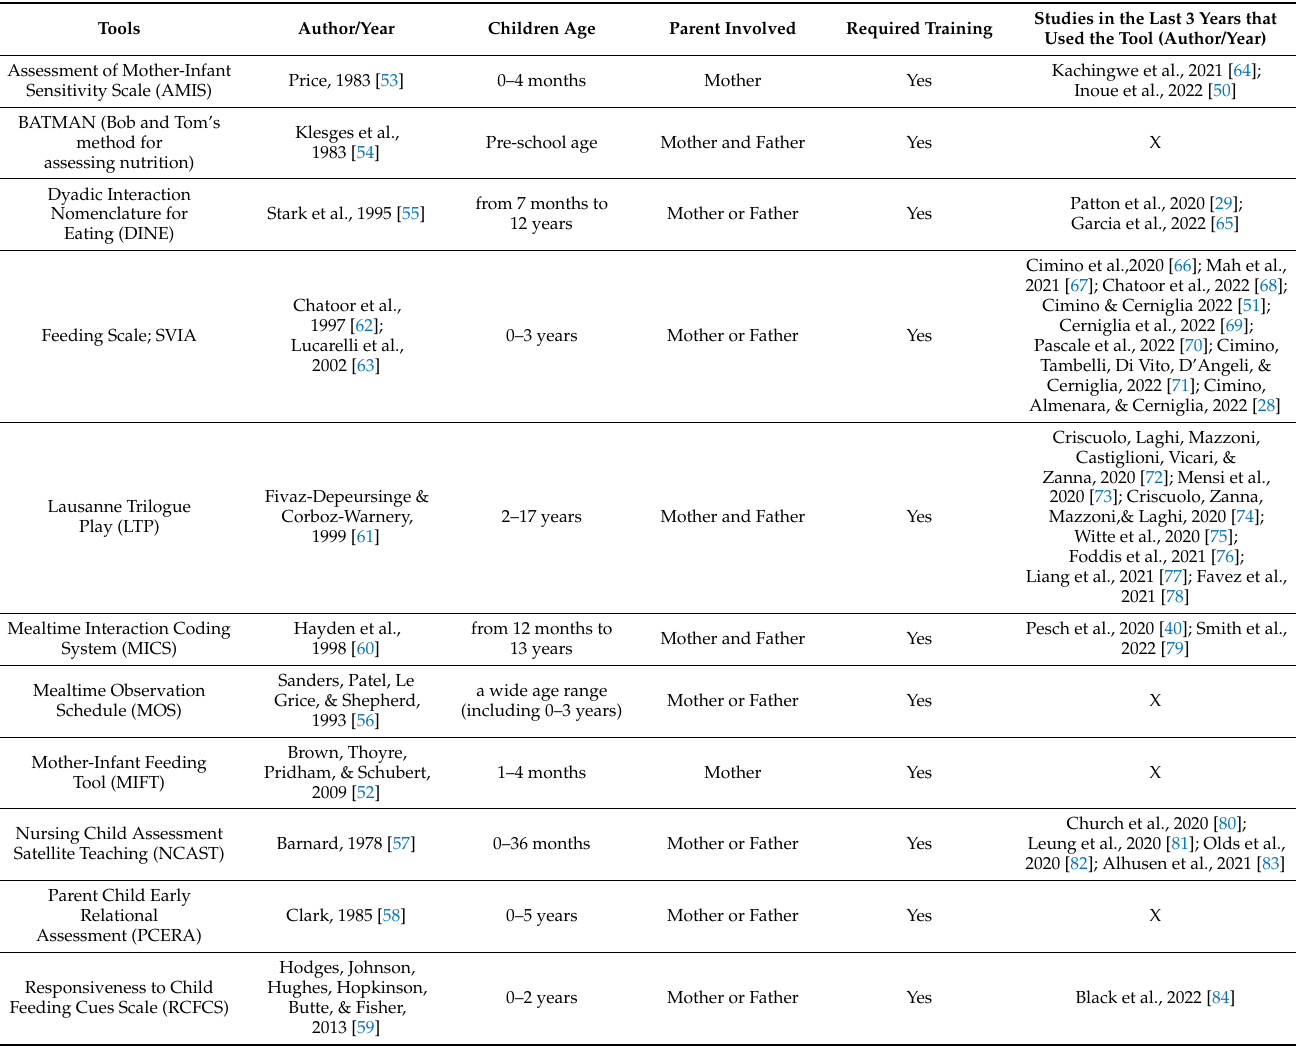
Table 3. Characteristics selected tools: Author/Year; Children age; Parent involved; Training; Re- cent